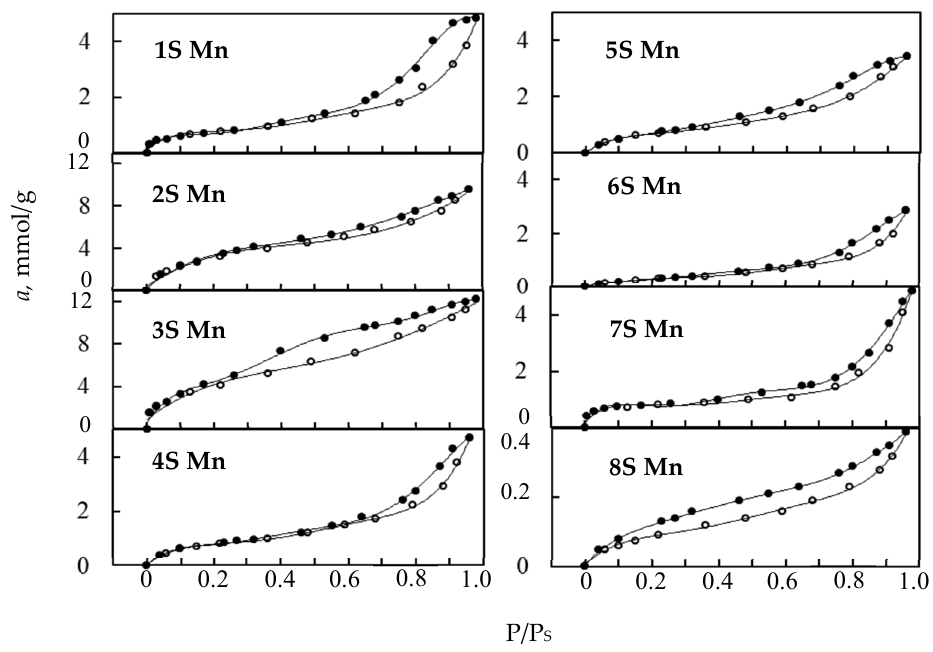
Figure 3. Water vapor adsorption‐desorption isotherms for the manganese oxide samples under study.